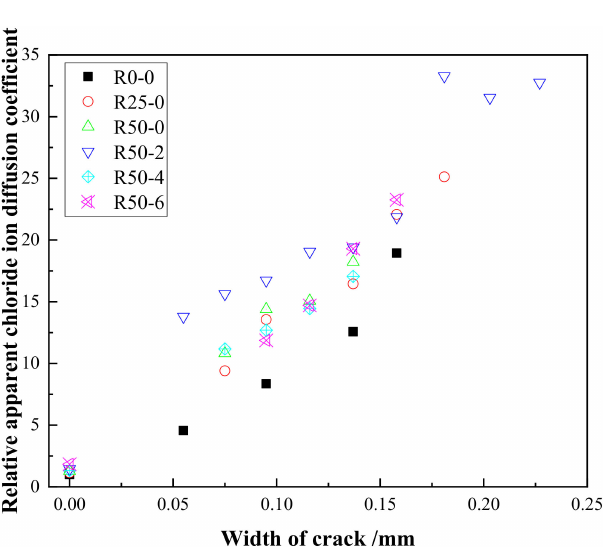
Figure 16. Relative apparent chloride diffusion coefficient at each crack after 50 wetting-drying cycles.